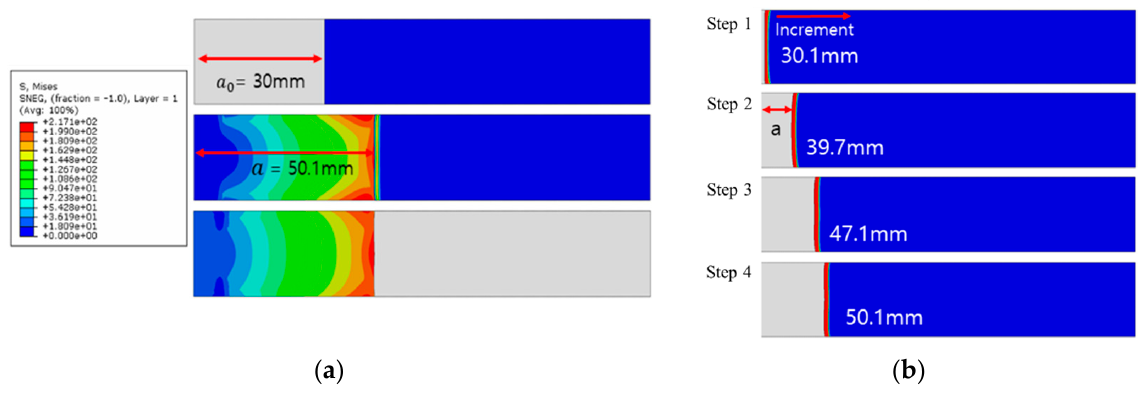
Figure 15. FE analysis result shape of Mode II: ( a ) in-plane stress contour and ( b ) crack growth length at applied displacement.